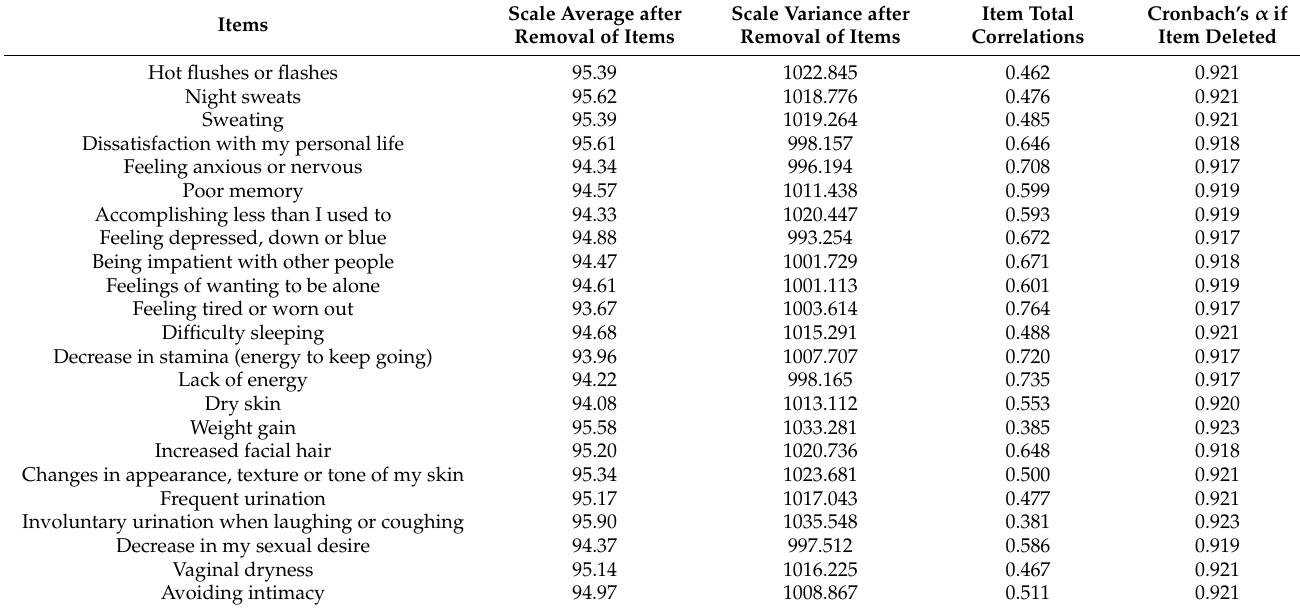
Table 4. Assessment of the reliability of the Polish version of the MENQOL scale. Scale Average after Scale Variance after Items Removal of Items Removal of Items